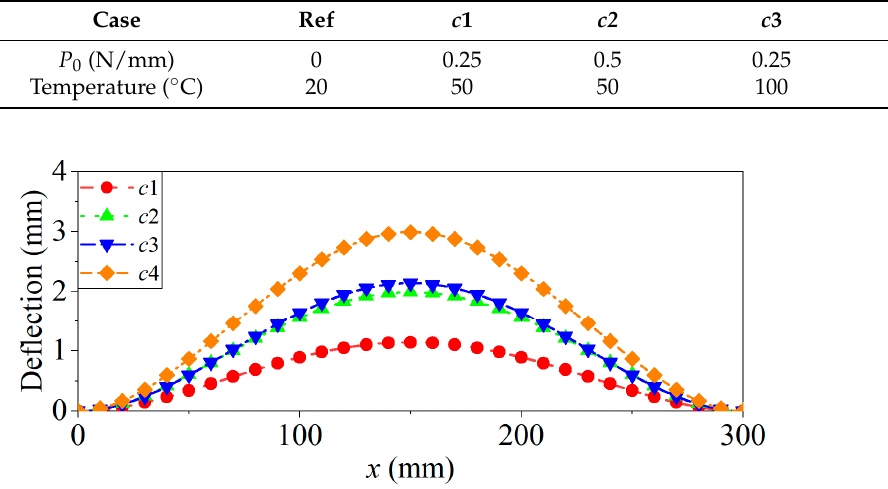
Figure 11. De fl ections of beams under di ff erent combined loads.